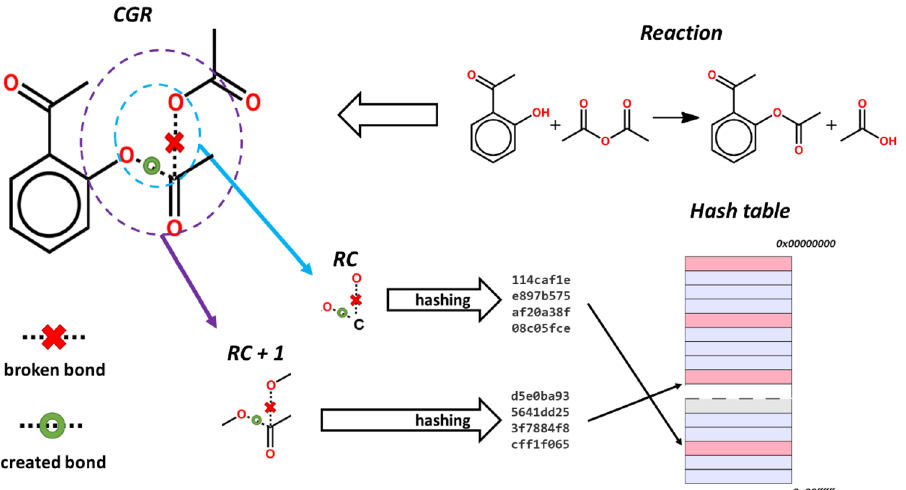
Figure 5. Preparation of a collection of reaction signatures as hash codes. From a CGR generated from a given reaction, substructural motifs containing reaction center (RC), or reaction center with n neighboring bonds and atoms (RC + n , here n = 1) can be extracted. Each motif is encoded by a hashing function into a unique hash code—reaction signature. The ensemble of unique hash codes for all reactions in the database is stored in the hash